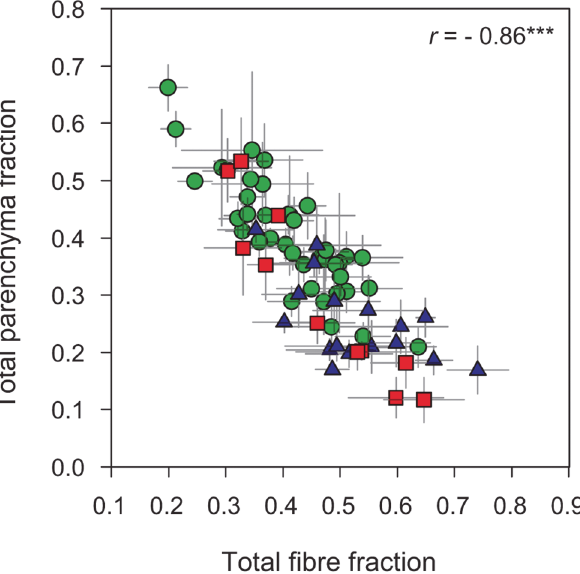
Fig 3. Relationship between total fibre fraction and total parenchyma fraction. Green circles — tropical rainforest (warm and wet site); red squares — tropical woodland (warm and dry site); blue triangles — temperate forest (cool and wet site). *** P <